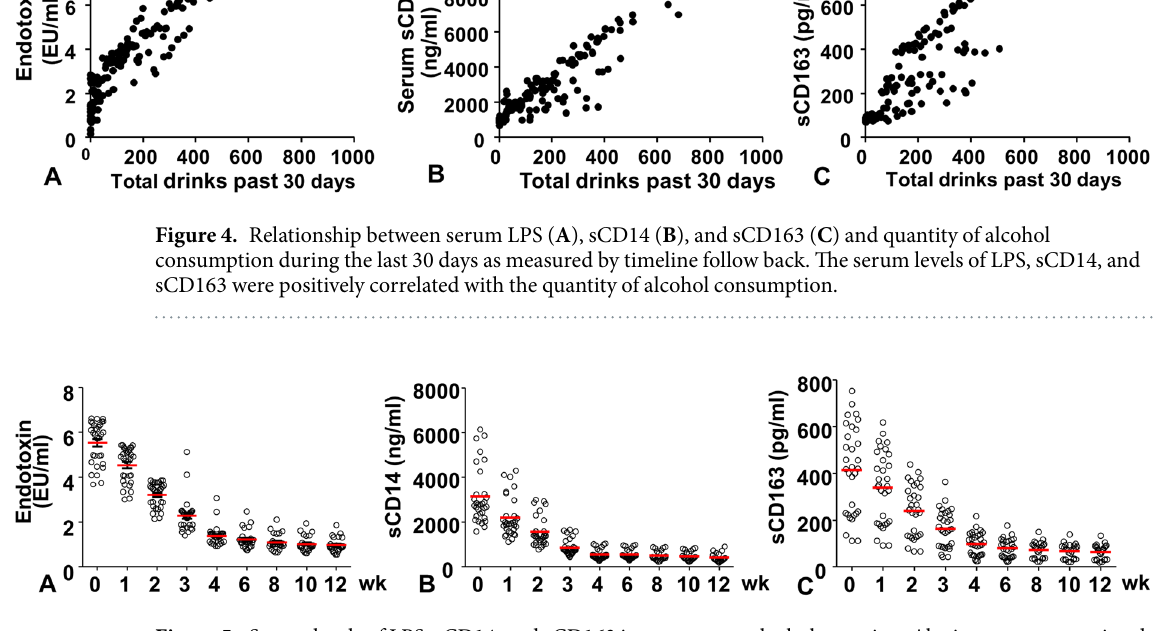
Figure 5. Serum levels of LPS, sCD14, and sCD163 in response to alcohol cessation. Abstinence was associated with significant decline in the levels of LPS ( A ), sCD14 ( B ) and sCd163 ( C